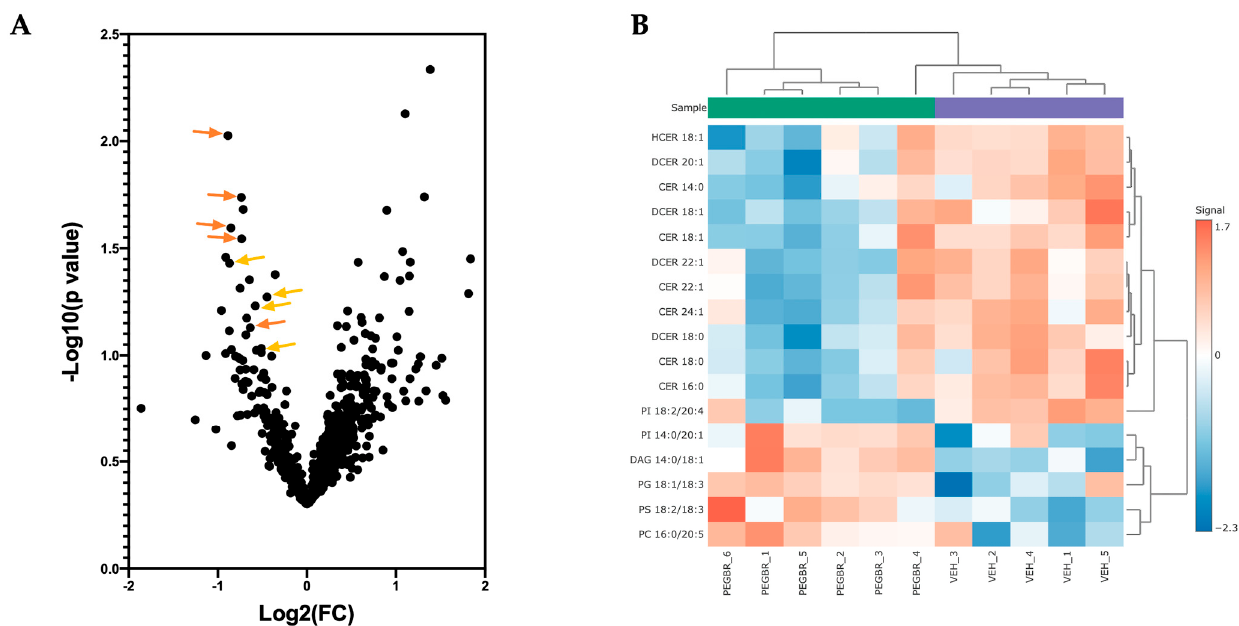
Figure 2. Bilirubin nanoparticles reduce the number of ceramides and dihydroceramides in the liver of obese mice. ( A ) A volcano plot showing all lipid species measured. The orange arrows point to ceramides, and the yellowish-orange arrows point to dihydroceramides. ( B ) A heatmap showing the most significantly different lipid species in the PEG-BR vs. VEH groups.